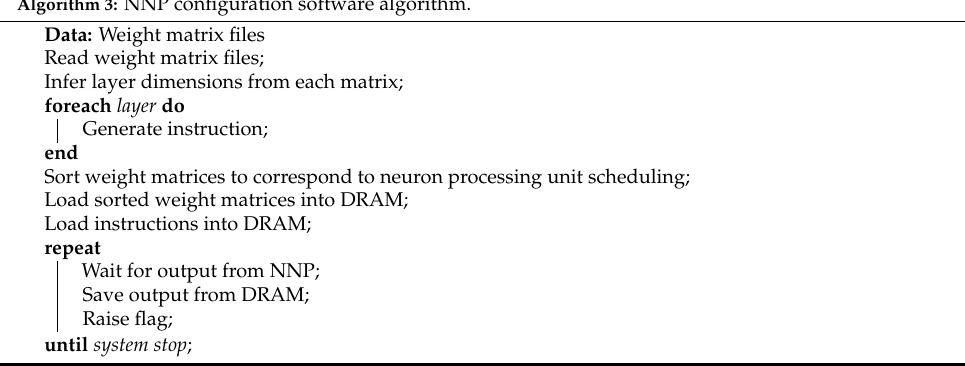
Algorithm 3: NNP configuration software algorithm.